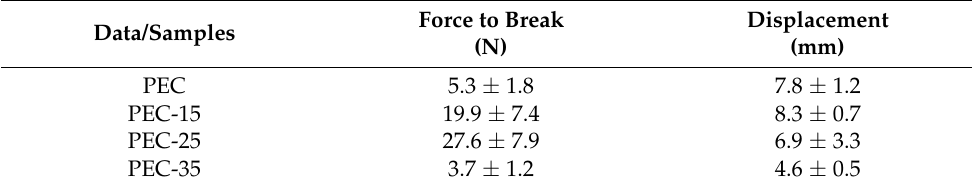
Table 5. Mechanical properties (puncture test) of the pectin film and biocomposites.